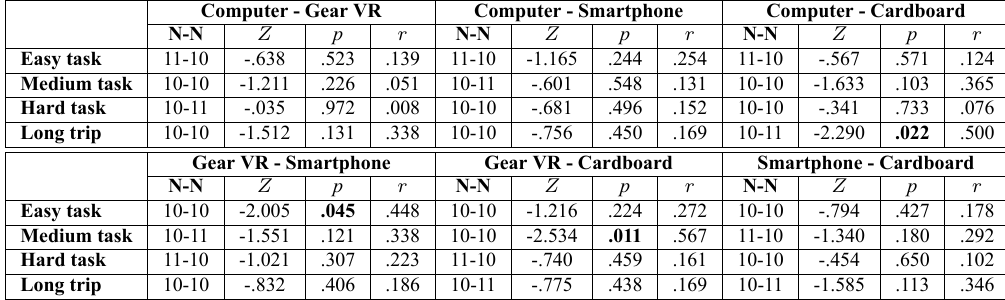
Table 10. Mann­Whitney U test for the elapsed time for all pairs of devices in each task and a between­subject